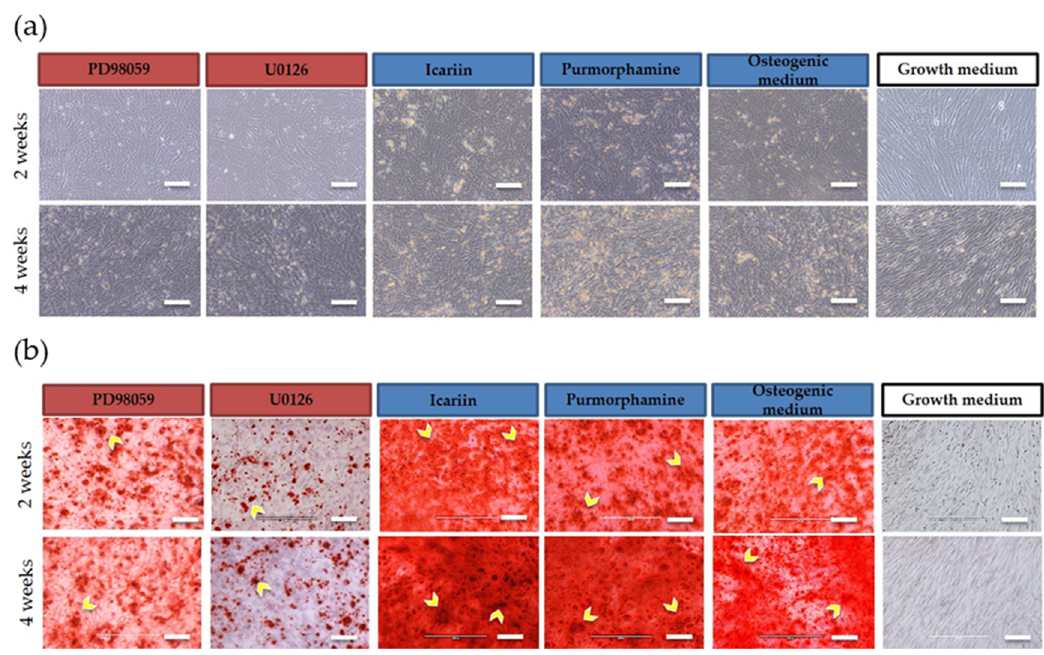
Figure 2. Images before ( a ) and after ( b ) Alizarin Red staining of 2D monolayer cultures (n = 3 per medium condition) at two weeks and four weeks in culture. Cells showed non-uniform calcium deposition, displaying zones of accumulation (dark red; indicated by yellow arrows) indicative of osteogenic differentiation (10× magnification, scale bar = 500 μm).